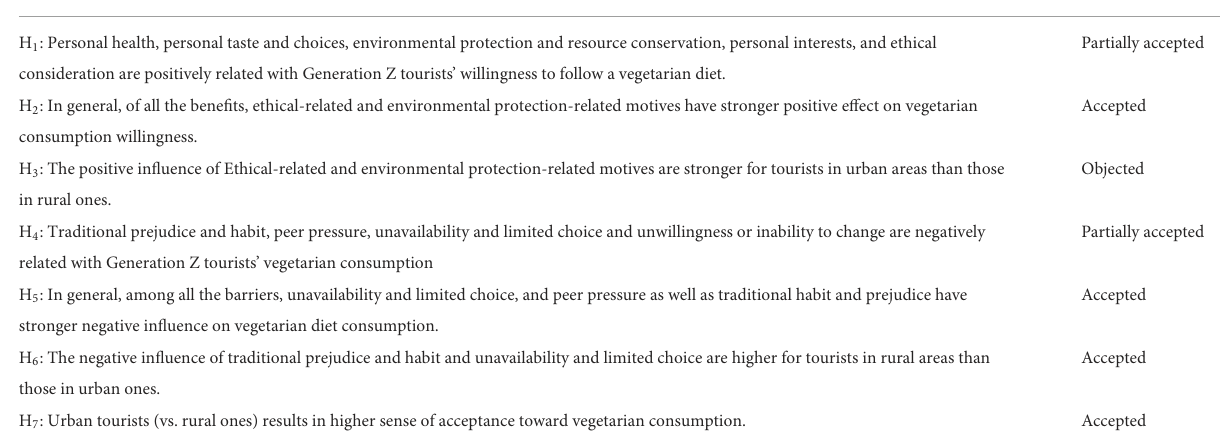
TABLE 13 Summary of hypotheses